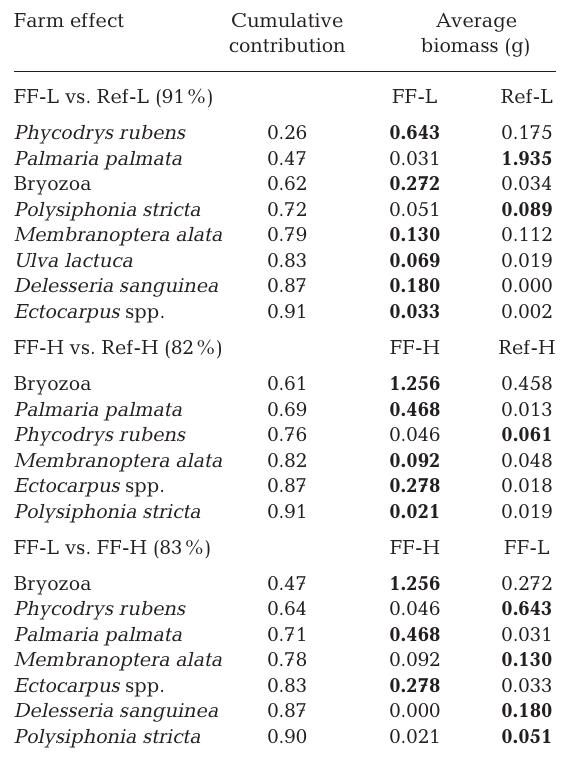
Table 4. Results from SIMPER analysis of Laminaria hyper- borea stipe epiphytes sampled from fish farm sites. Cumula- tive contribution of species up to 90% of the dissimilarities between tested group-pairs is presented, with the average biomass (standardized to 10 cm 2 ungrazed stipe) for each contributing species. Bold indicates the highest biomass for each species within each group-pair. Percent in brackets refers to overall dissimilarity for the respective group-pairs (see Table S3 for species